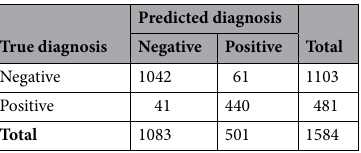
Table 3. Confusion matrix for the ten-fold cross-validation, classifier built only on thermal images (last row in Table